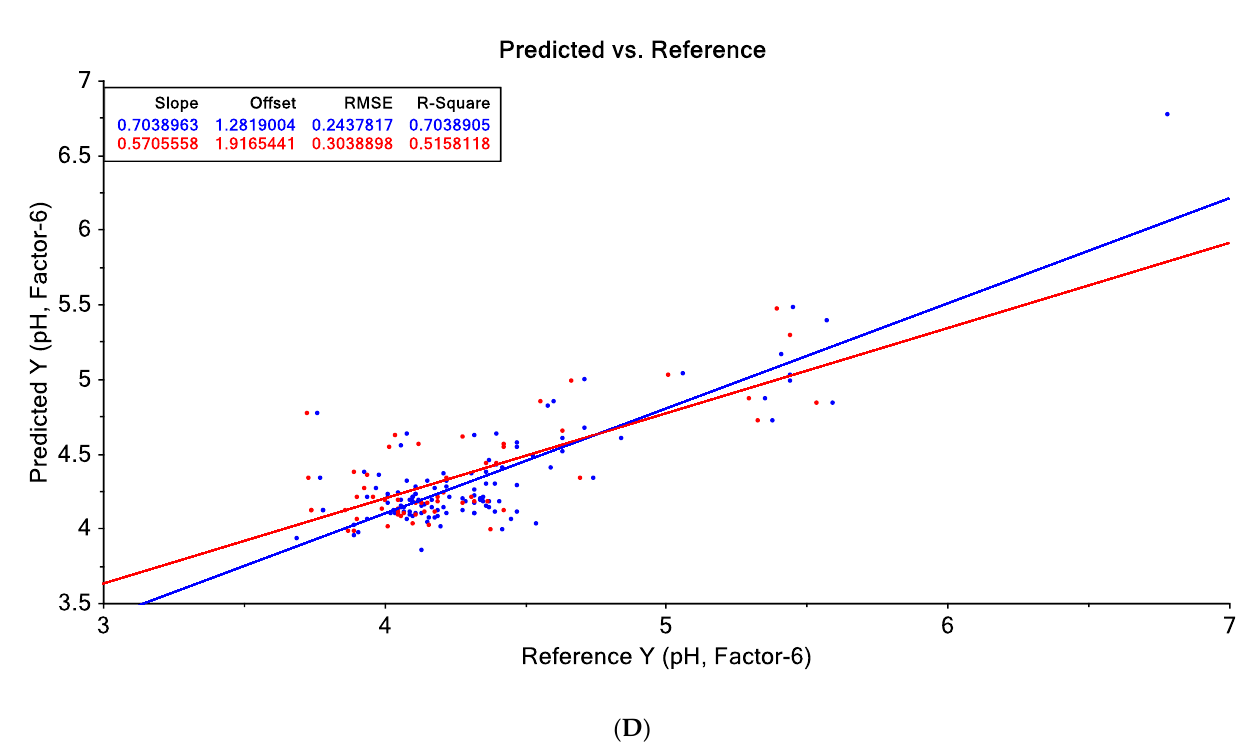
Figure 6. Experimental vs. predicted data using PLSR for: ( A ). EC prediction using minimum and maximum intensity of the current obtained for all the electrodes, ( B ). EC prediction using minimum intensity of the current obtained for all the electrodes, ( C ). EC prediction using maximum intensity of the current obtained for all the electrodes and ( D ). pH prediction using minimum and maximum intensity of the current obtained for all the electrodes.